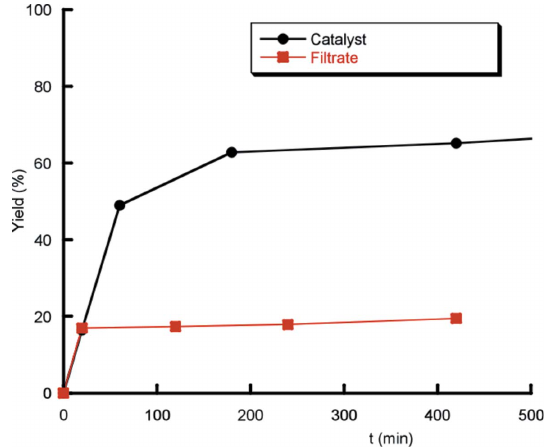
Figure 9 Kinetic profile of the condensation of benzaldehyde with malononitrile over compound 2 after hot